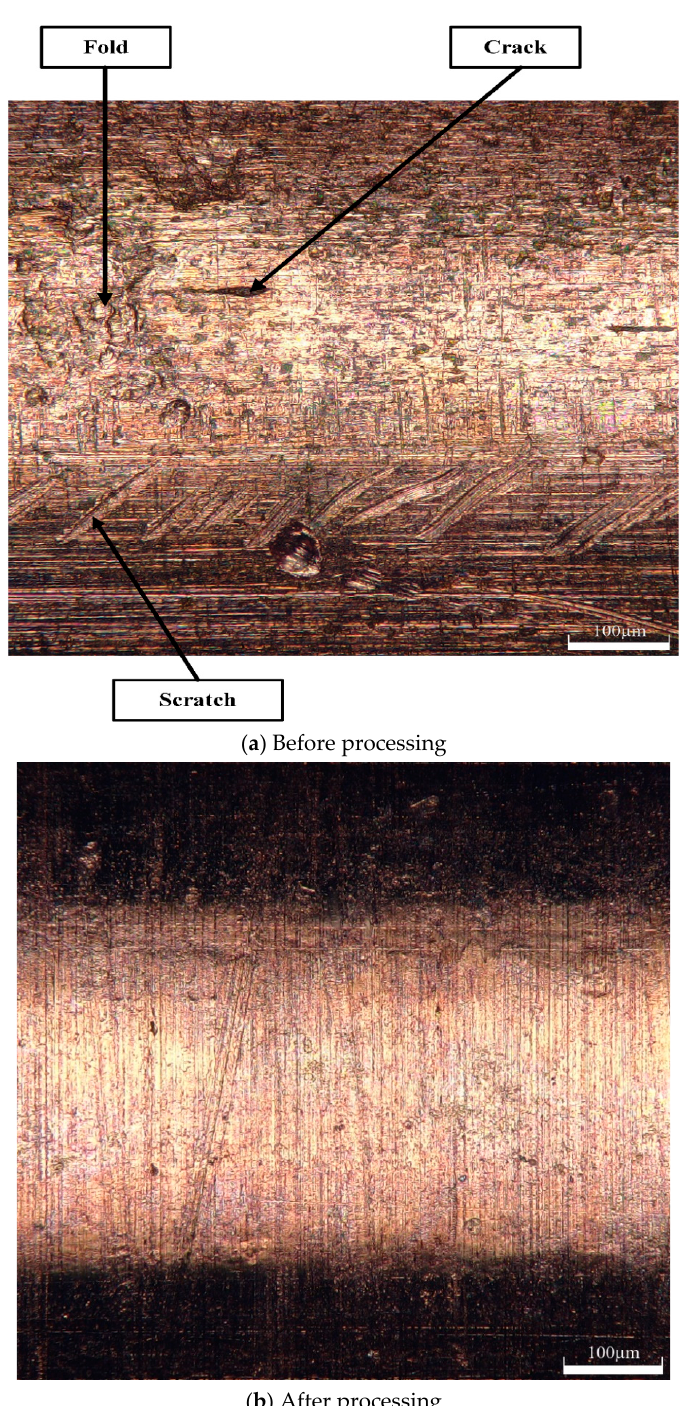
Figure 13. 3D digital micrographs of the outer surface of the tube before and after processing.